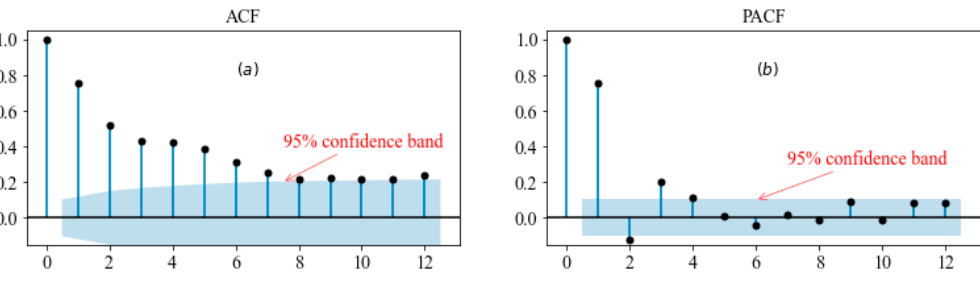
Figure 3. The ACF plot ( a ) and PACF plot ( b ) of Yunnan wind power.